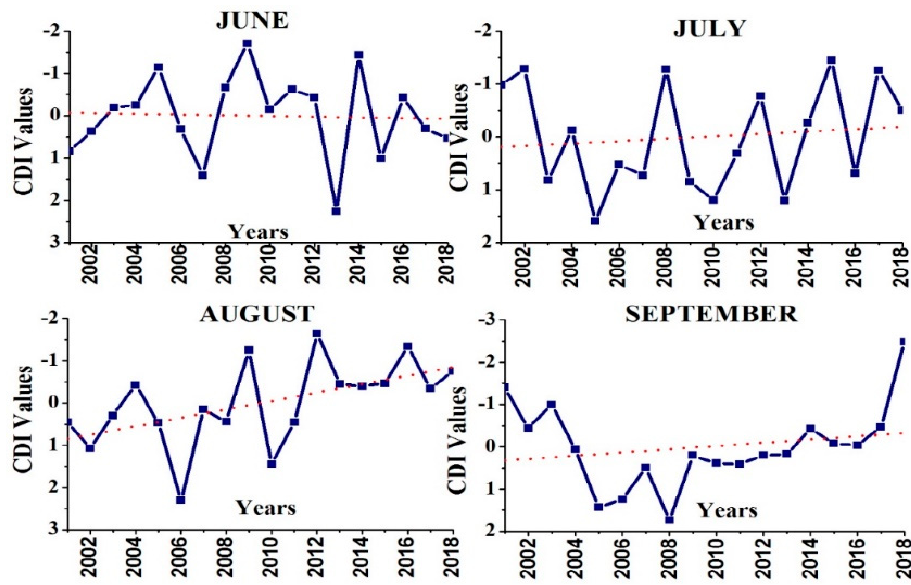
Figure 8. Trends in CDI_M over the monsoon months .